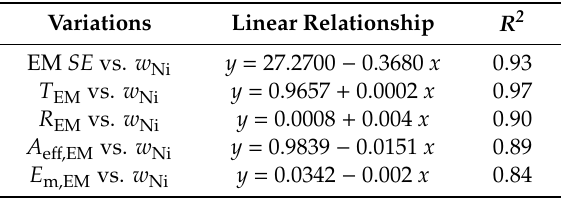
Table 3. Linear relationship between the EMI results and w Ni.